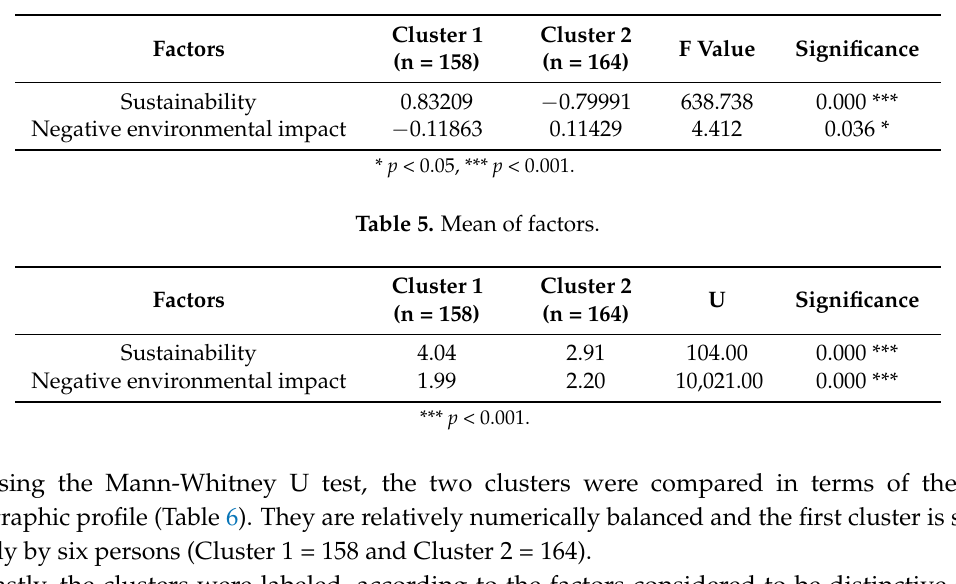
Table 4. Final cluster centers.